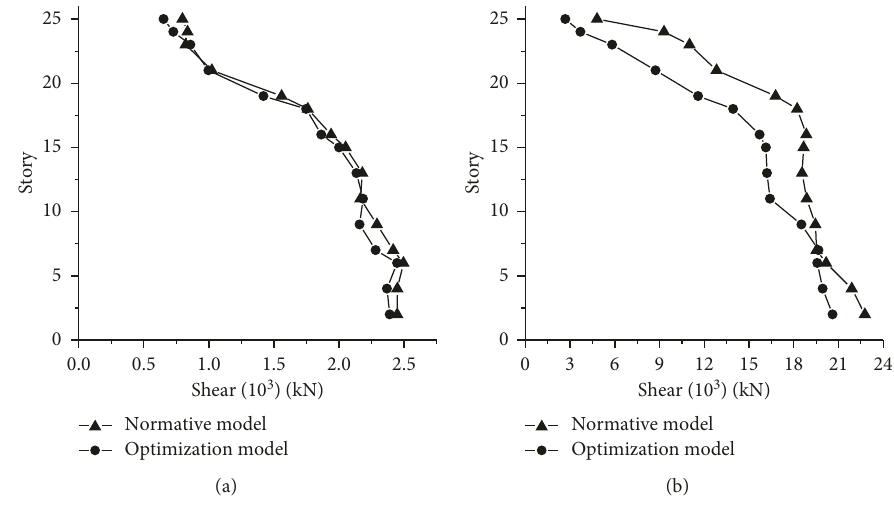
Figure 19: Comparison of story maximum shear. (a) Frequent intensity 7; (b) rare intensity